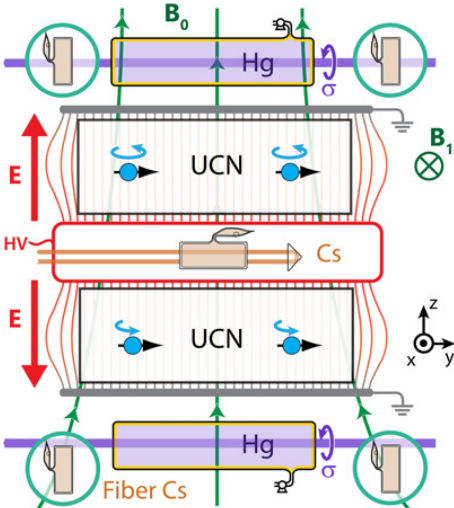
Figure 1. Central elements of the PanEDM double-cell spec- trometer. Two cylindrical storage cells are filled simultaneously with UCN from a common source, and subjected to a common applied magnetic field | B 0 | ≈ 1 . 3 µ T. Equal and antiparallel electric fields with | E | ≈ 2MV/m are applied via conductive end- caps, including a common high-voltage electrode in the center. Optical magnetometers based on laser spectroscopy of room- temperature 199 Hg and 133 Cs in cells are arranged around the UCN storage chambers, including Cs sensors with cells inside the hollow central